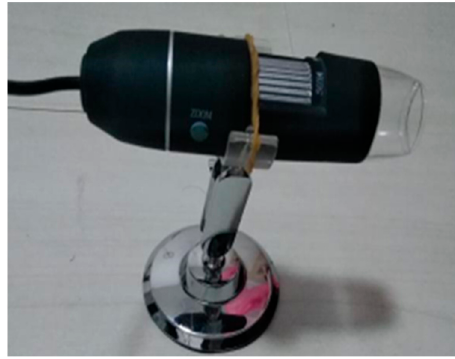
Figure 5. USB digital microscope.